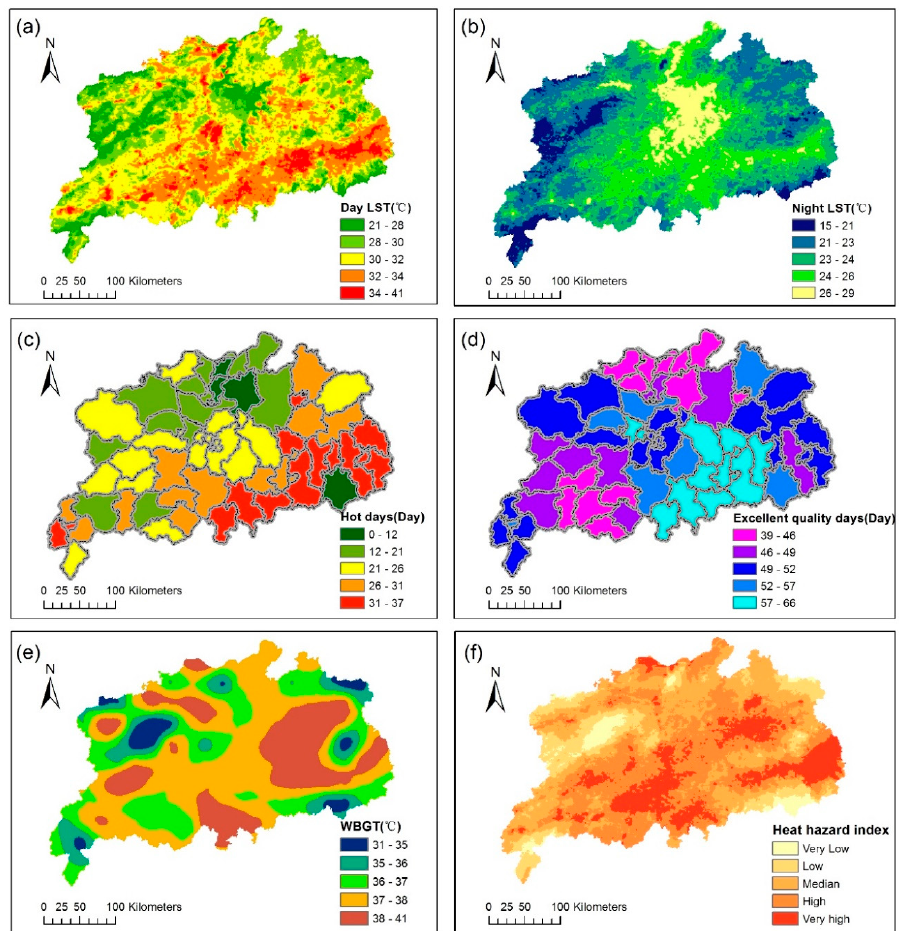
Figure 4. ( a ) daytime land surface temperature (LST); ( b ) nighttime LST; ( c ) the annually average number of days with the highest temperature > 35 ◦ C in each county from 2015 to 2018; ( d ) the